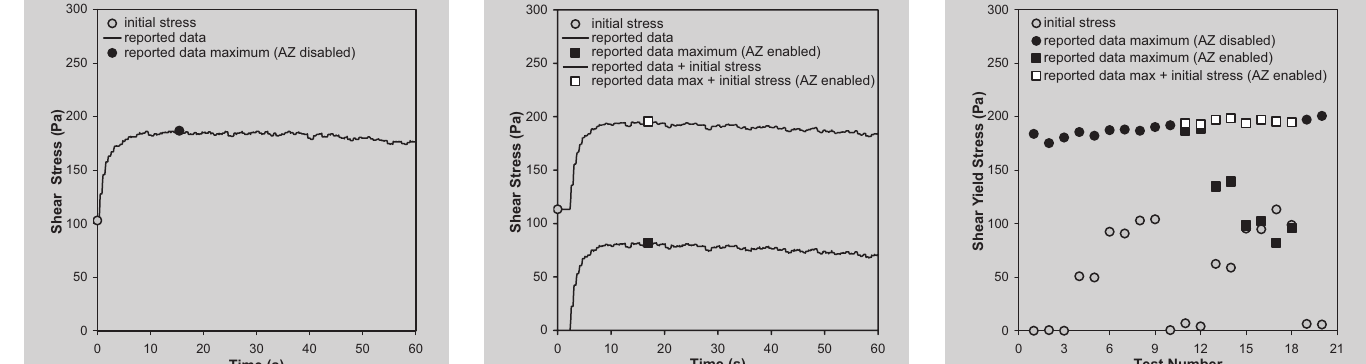
Figure 1 (left): A single vane yield stress measurement for a 0.56 w/w nickel laterite suspen- sion using a Haake rheome- ter with the torque auto zero (AZ) disabled (chart shown is that of Test 8 in Fig. 3). Figure 2 (middle): A single vane yield stress measurement for a 0.56 w/w nickel laterite suspen- sion using a Haake rheome- ter with the torque auto zero (AZ) enabled (chart shown is that of Test 17 in Fig. 3). The dashed curve was obtained by shifting the curve reported by the software (solid line) vertical- ly by a magnitude equiva- lent to the initial stress. Figure 3: Vane yield stress measure- ment results for a 0.56 w/w nickel laterite suspension using a Haake rheometer with the torque auto zero (AZ) both enabled (squares) and disabled (circles). The respective initial stress for each test (crosses) relates to the stress induced on the vane fixture immediately prior to the commencement of the yield stress test. ‘reported stress’ is that given by the software. Yield stresses were determined by the maximum torque response at a constant vane rotation rate (see Figs. 1